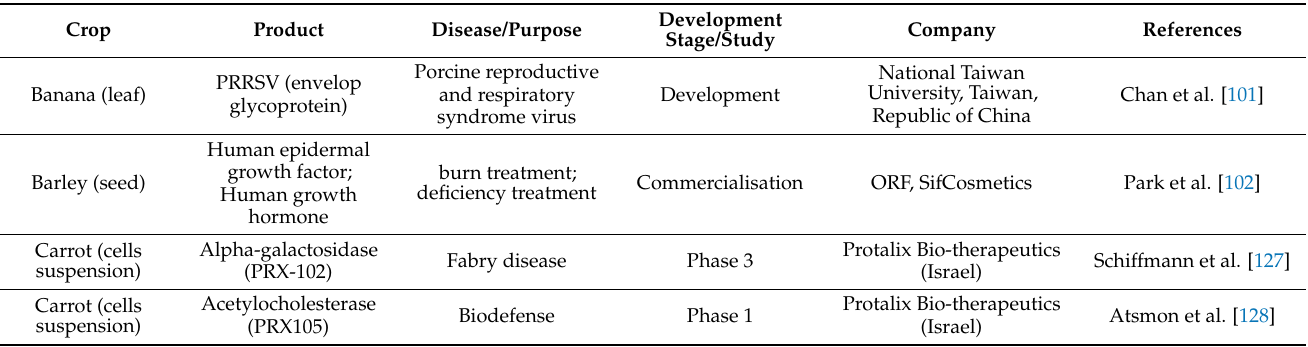
Table 4. Examples of food crop PMPs at miscellaneous stages of